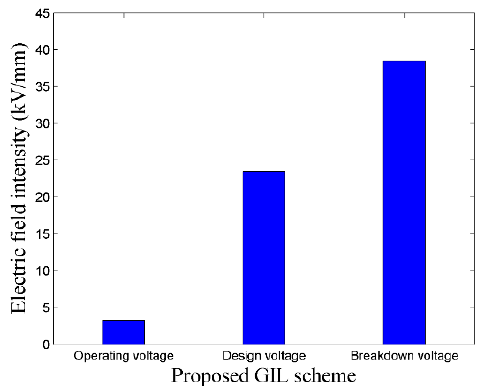
Figure 19. Electrostatic field comparison for suggested FGIL scheme regarding operating voltage, design voltage and BV.